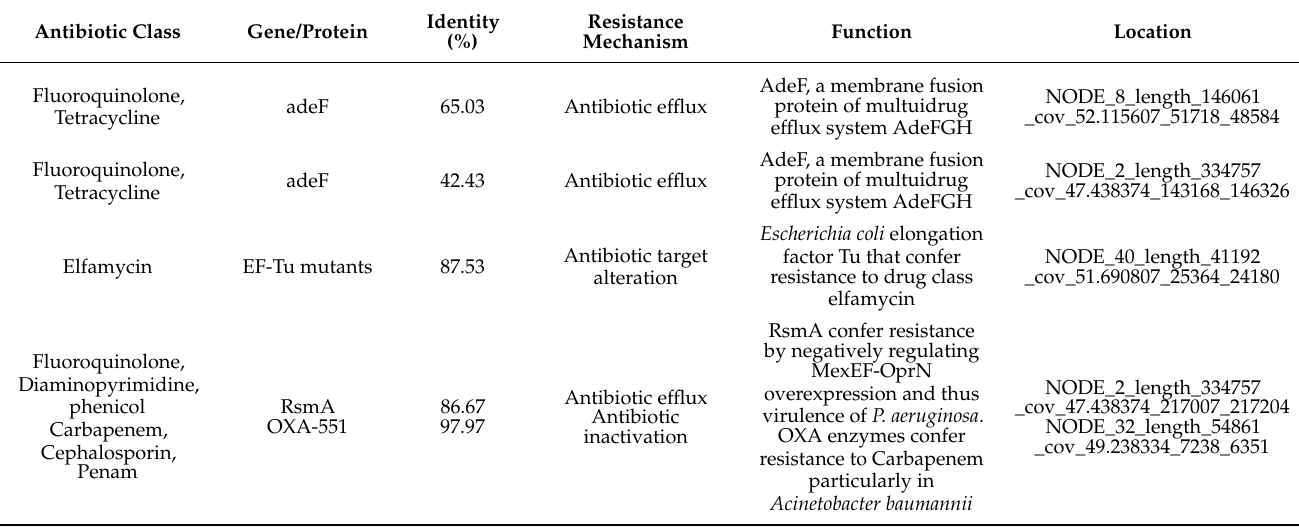
Table 2. Antibiotic resistant gene prediction of Shewanella sp. N2AIL